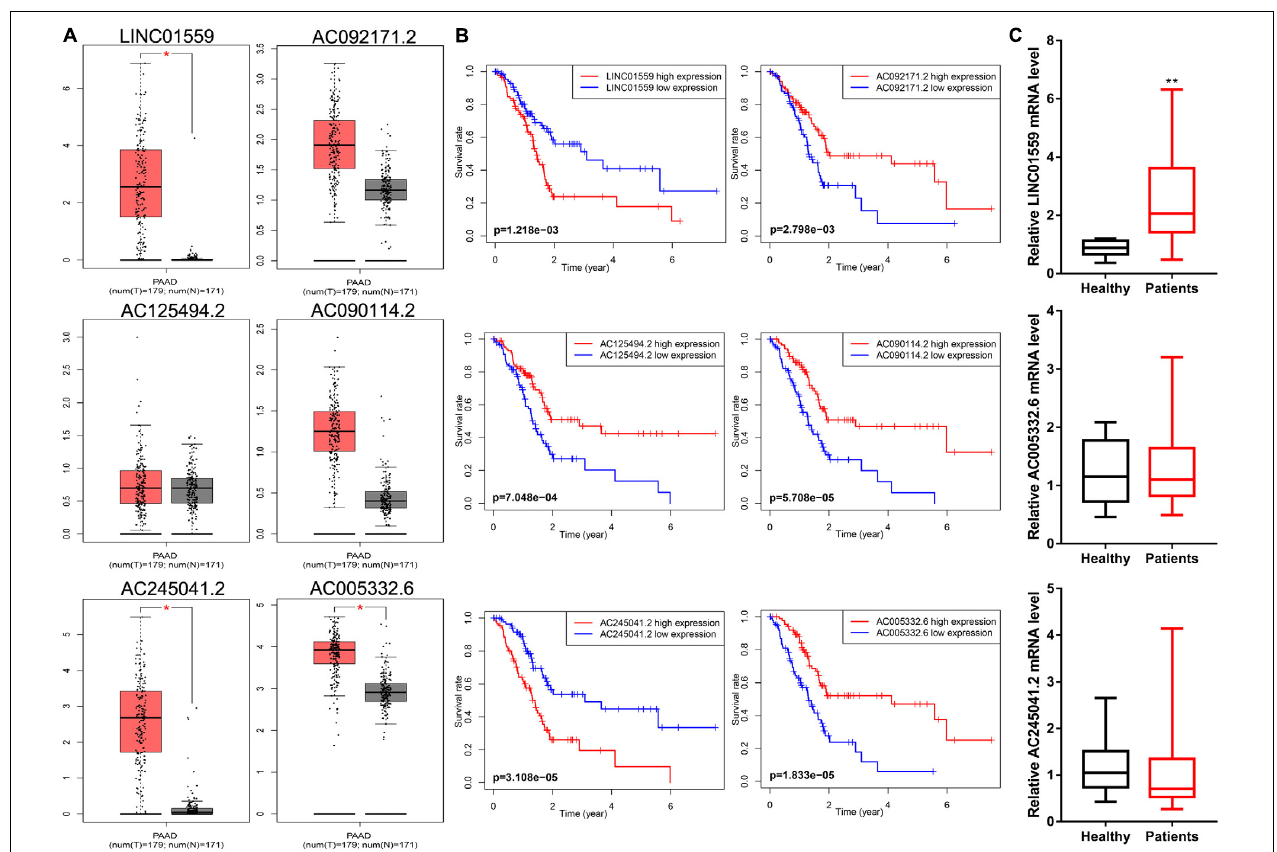
FIGURE 9 | LINC01559 serves as a diagnostic biomarker. (A) Comparison of differential expression of signature lncRNAs by GEPIA. (B) Kaplan-Meier survival curves for the signature lncRNAs. (C) qRT-PCR was conducted to detect the expression levels of LINC01559, AC245041.2, and AC005332.6 in serum (* p < 0.05; ** p < 0.01; ns, not